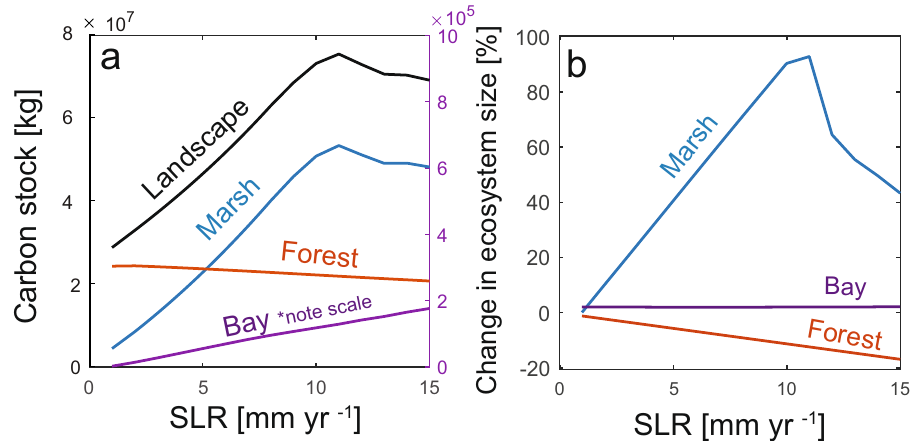
Fig. 4 | Carbonstocksandecosystemsizesdepend onsealevelrise(SLR)rates. a Total landscape carbon stock, comprised of marsh, forest, and bay ecosystems vary with SLR. b Shifts in landscape carbon stocks depend on the size of each